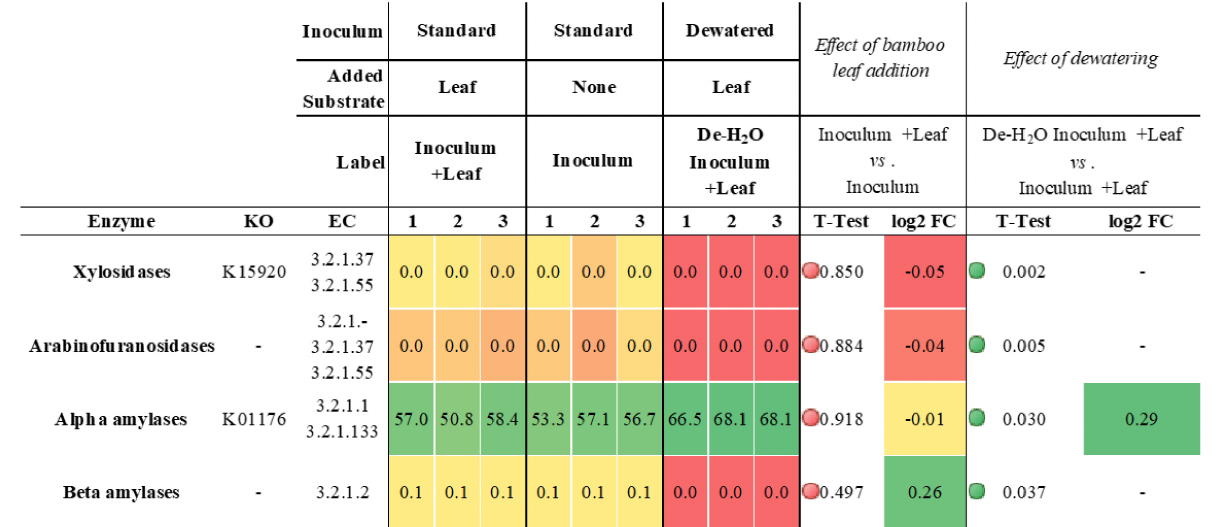
Table 2. Expression of carbohydrate active enzymes (CAZy; www.cazypedia.org, accessed on 6 May 2020) in In vitro incubation tests with microbiomes derived from giant panda fecal samples (see Figure 1 for the experimental setup). Enzymes were grouped according to their function (see KO and EC numbers). The full list of metaproteins and their taxonomy is reported in Table S3A. The heat map, red (low) to green (high), indicates increasing relative abundance or log2 fold changes (log2FC). Red or green circles in TTEST indicate statistical significance ( p <